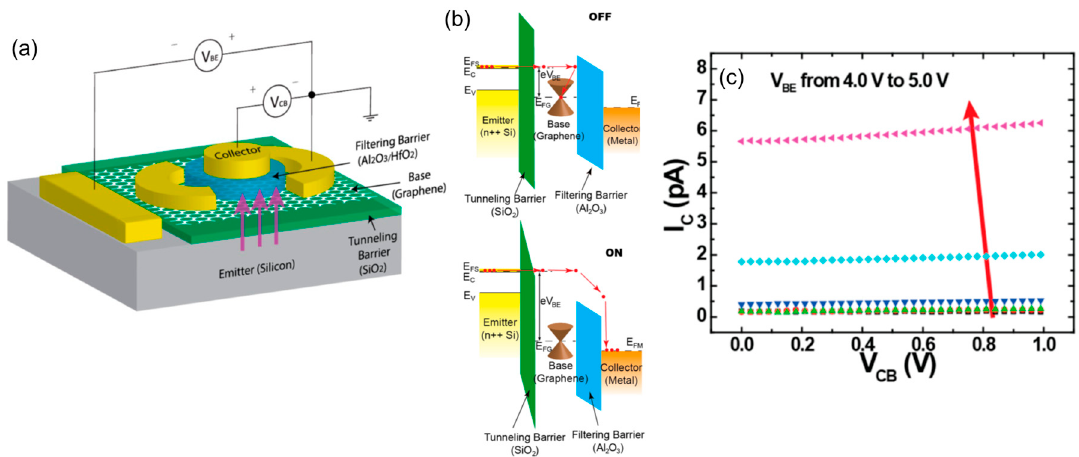
Figure 8. ( a ) Schematic illustration of a Si/SiO 2 /Gr/Al 2 O 3 /Ti Gr-based hot electron transistor (HET) (GBHET) biased in the common base configuration; ( b ) band diagrams in the OFF and in the ON state; and ( c ) output characteristics I C -V CB of the device. Figures adapted from [23].